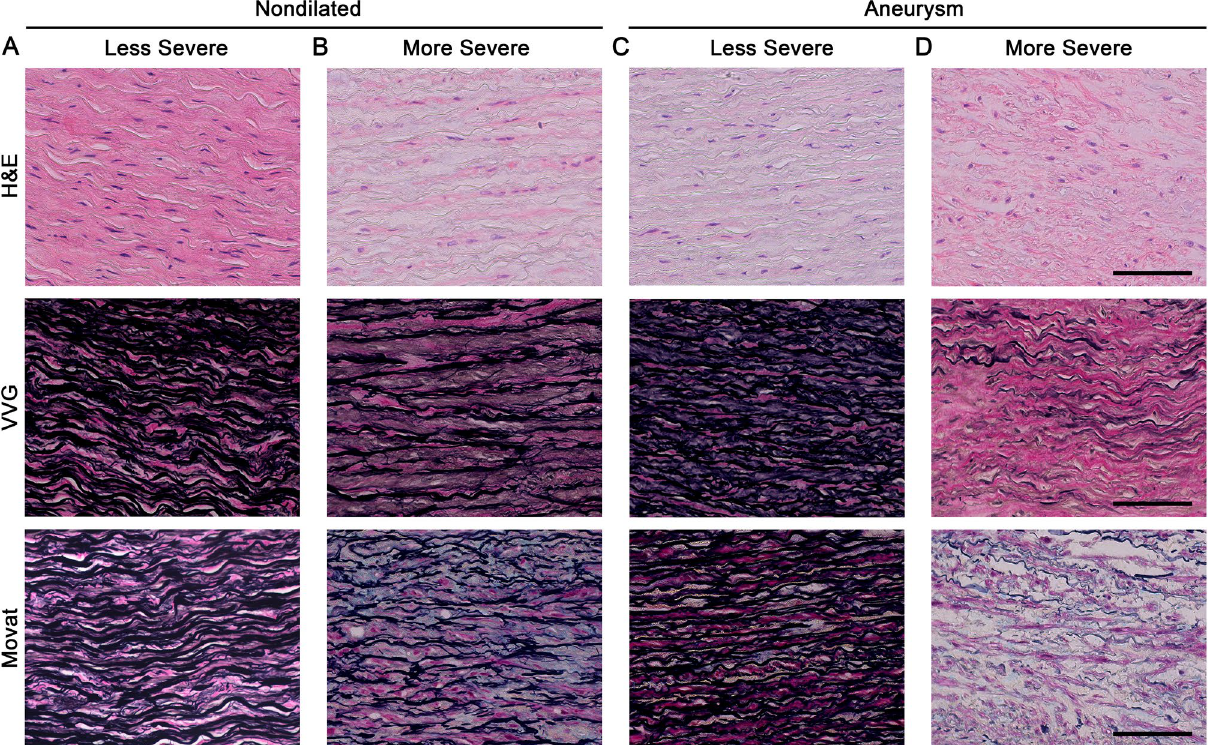
Movat and graded. A wide range of abnormalities from less to more severe were found and examples are shown from ( A ) 18-year-old male with 2.6 cm aorta, ( B ) 60-year-old female with 3.2 cm aorta, ( C ) 51-year-old male with 6.5 cm aorta, and ( D ) 74-year-old male with 5.9 cm aorta. Scale bars represent 100